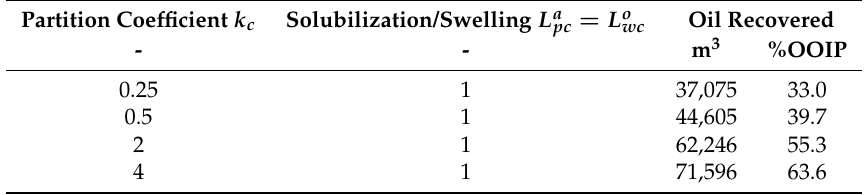
Table 5. Oil recovery efficiency in a random permeability field as a function of the partition